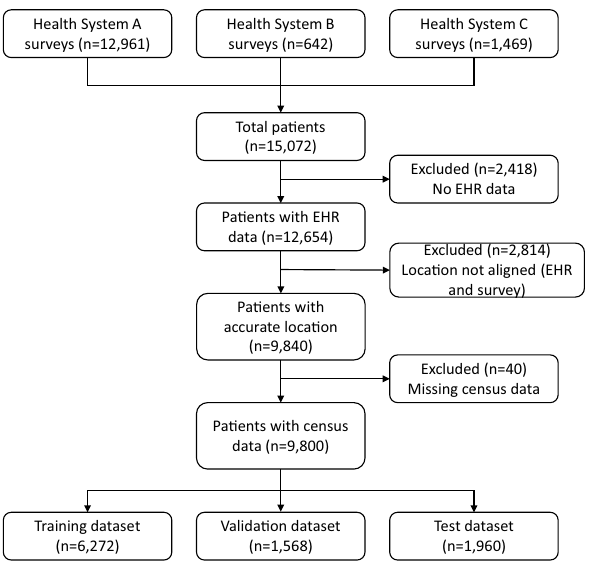
Figure 2. Consort flow diagram. Consort flow diagram depicting the sample size at each step of the data linkage. The diagram moves downward with each step displayed as a rectangle. Patients were excluded from the final datasets if they had no EHR data, if there was not alignment with the EHR and survey addresses, and if their geocoded location was missing corresponding Census data. These exclusions are depicted as rectangles with arrows along the diagram indicating where a patient sample was excluded. From these exclusions, the bottom and final three rectangles depict the training, validation, and test datasets included in the data